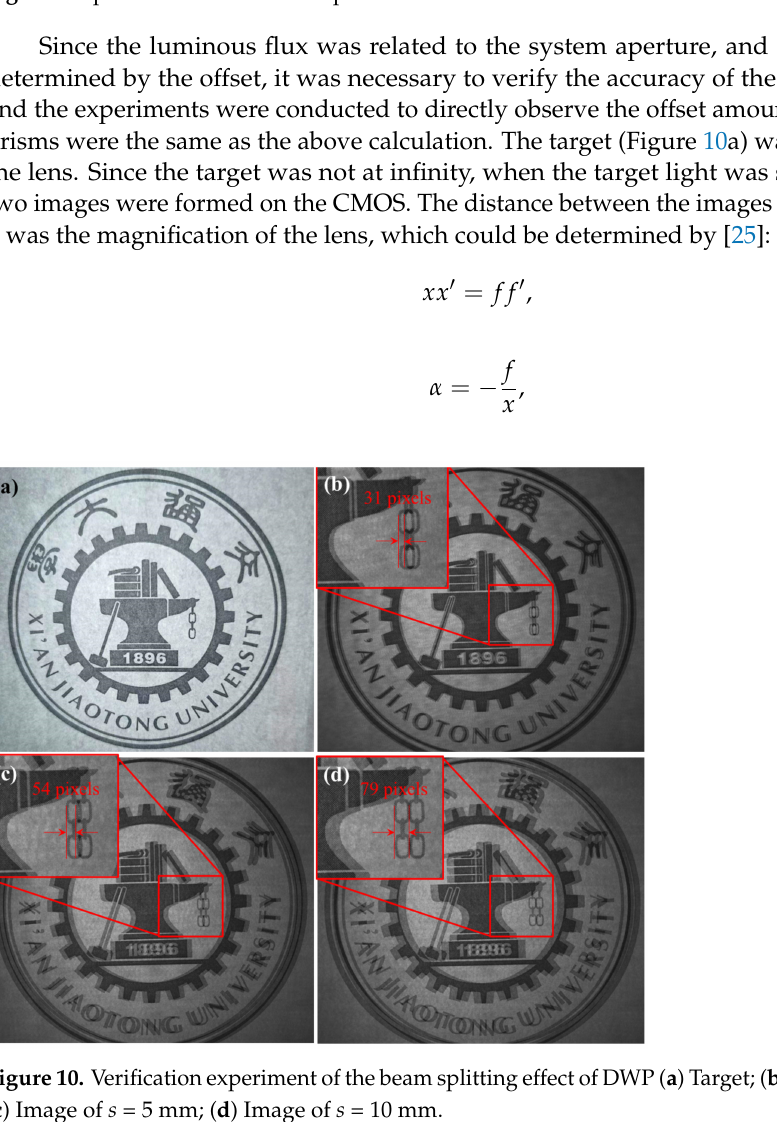
Figure 9. Spatial distribution of displacement with different s .